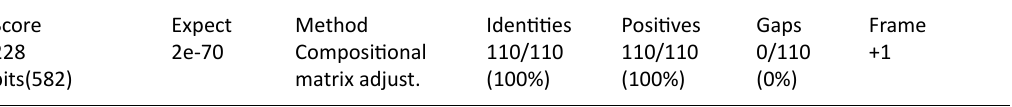
table 6. Alignment of hemolysin activation protein [ Proteus mirabilis ] Sequence ID: WP_074561482.1 Length: 561 Identical proteins to WP_074561482.1